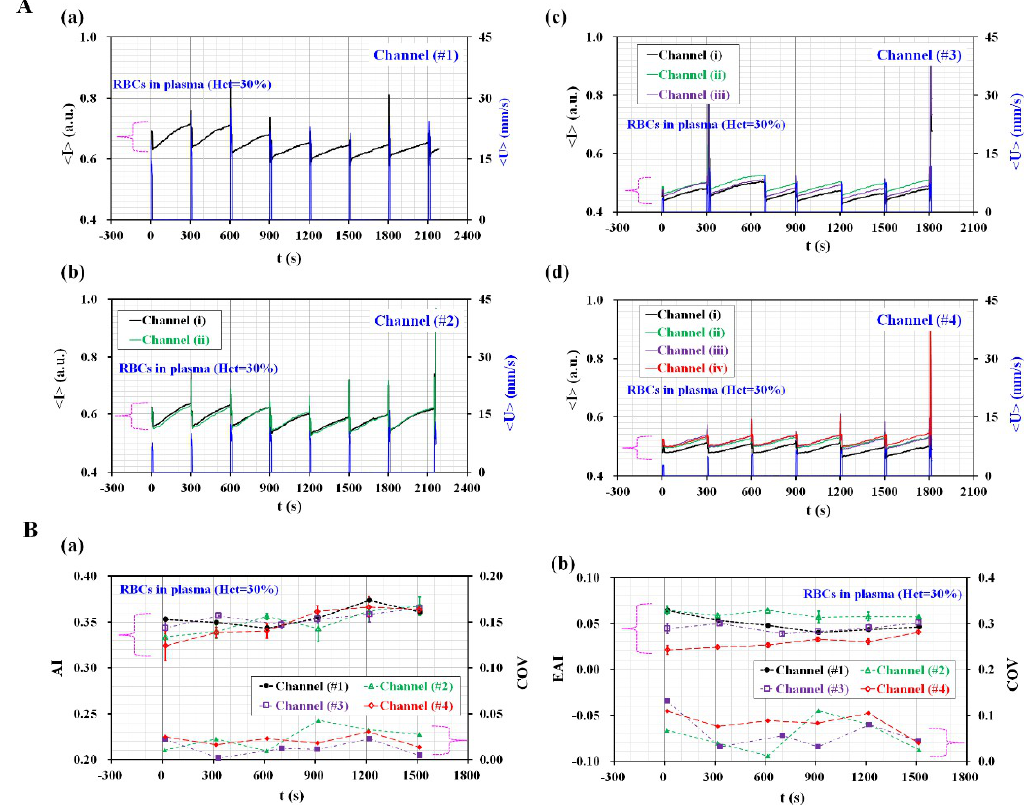
Figure 5. Quantitative evaluation of channel numbers for measuring scattering of two indices (AI and EAI). ( A ) Temporal variations of < U > and < I > with respect to channel number ( n ) (( A-a ) n = 1, ( A-b ) n = 2, ( A-c ) n = 3, and ( A-d ) n = 4). ( B ) Temporal variations of AI and EAI with respect to channel number. ( B-a ) Temporal variation of AI and, coefficient of variation (COV) with respect to channel number. ( B-b ) Temporal variations of EAI and COV with respect to channel number.